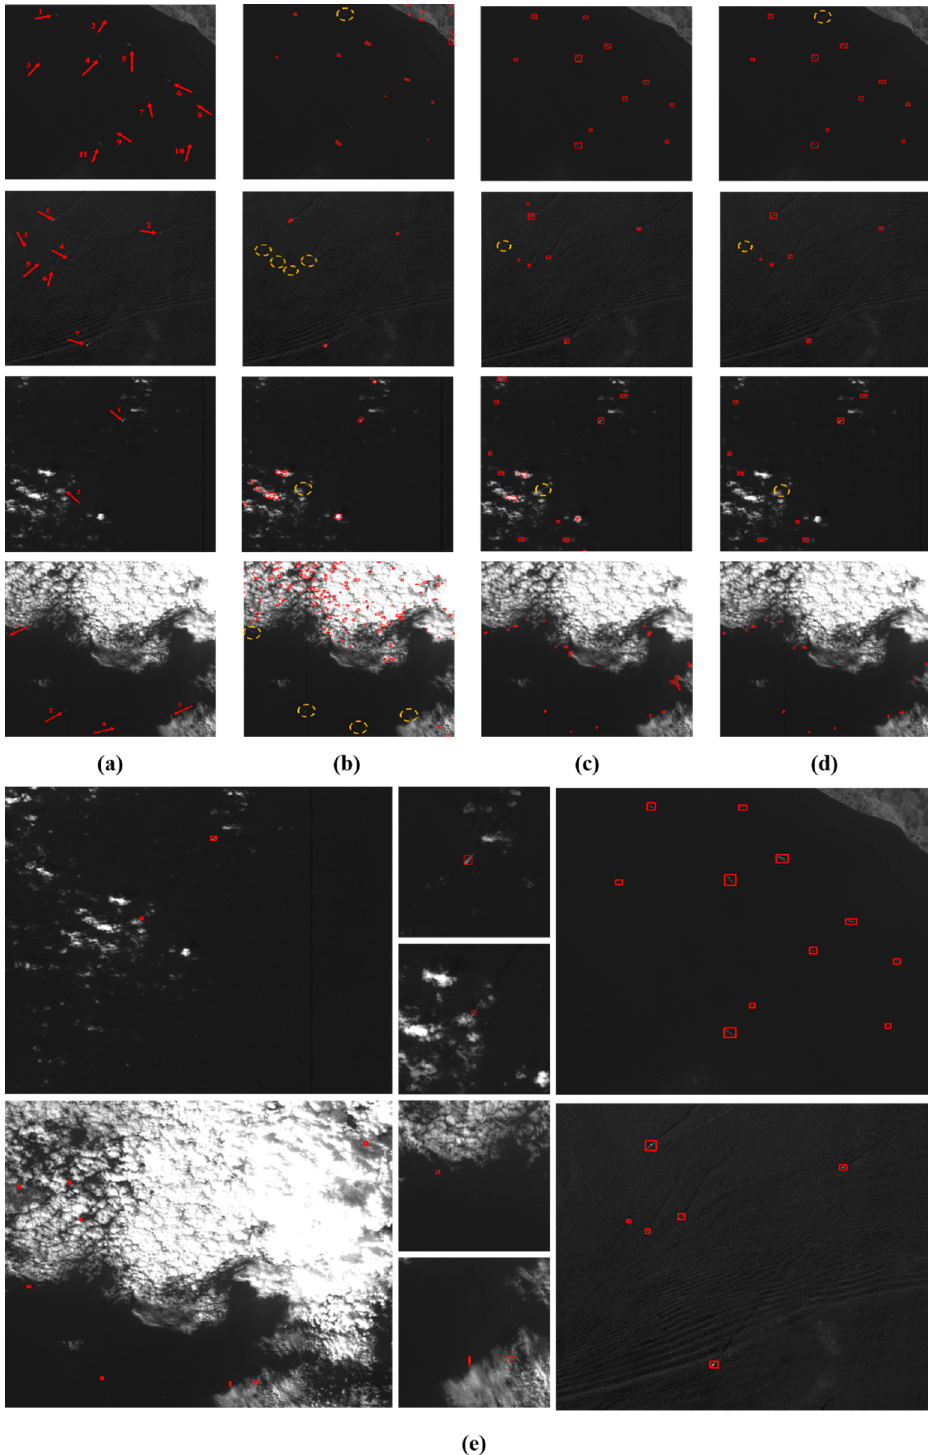
Figure 14. Comparison of methods of ocean ship detection performance with different scene cases. ( a ) original images; ( b ) PCT + Context + Modified modified scale invariant feature transform (SIFT) detection results; ( c ) Coarse Ship location + ELM detection results; ( d ) SVDnet detection results; and ( e ) proposed ocean ship detection framework performance with the local scene cases.